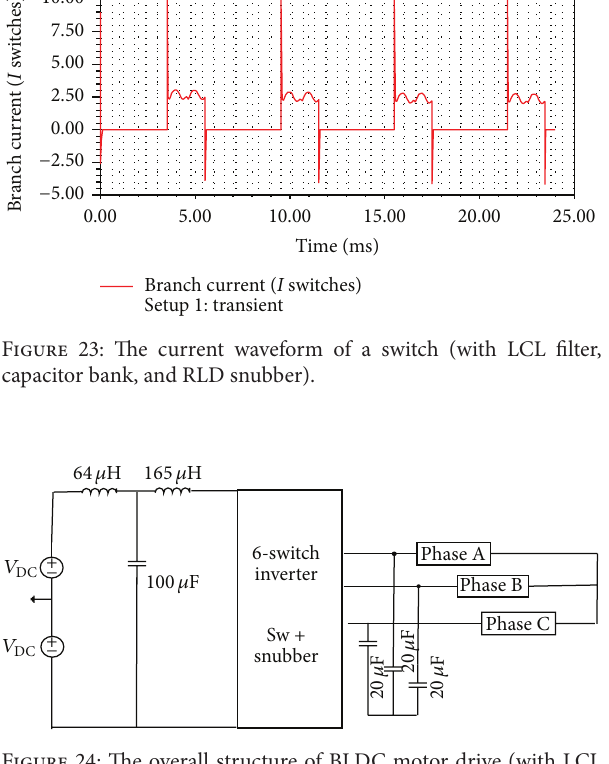
Figure 24: The overall structure of BLDC motor drive (with LCL filter, capacitor bank, and RLD snubber).